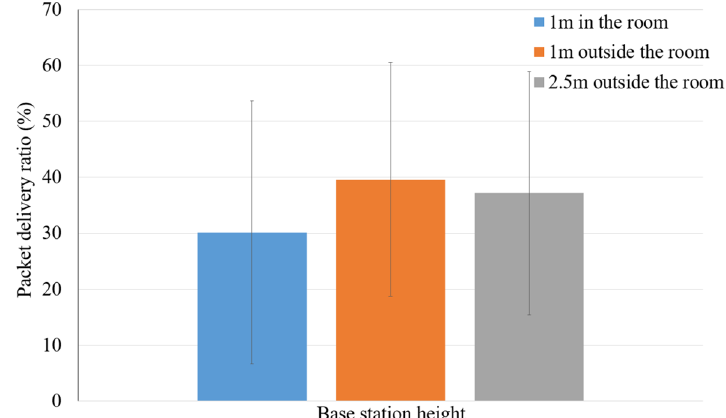
Fig. 14 The PDR for the test case